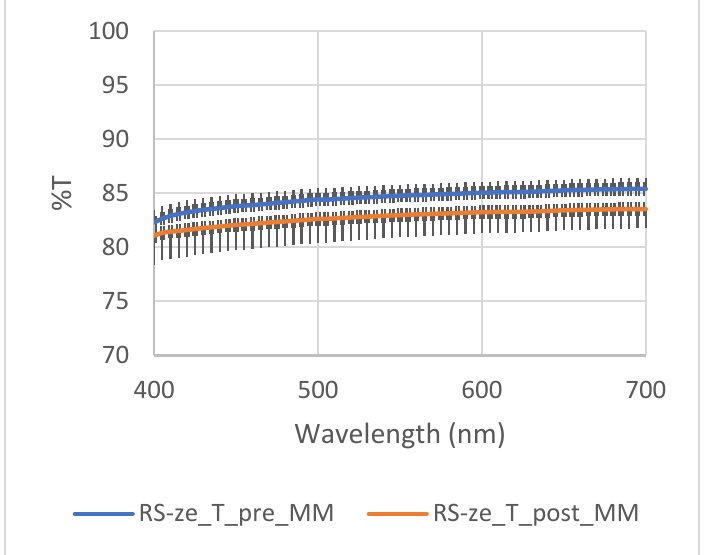
Figure 11. Transmittance values of the Zendura FLX with RapidShape D100+ printer analyzed before and after aging. The curves are the average of nine spectrophotometry values ± SD.